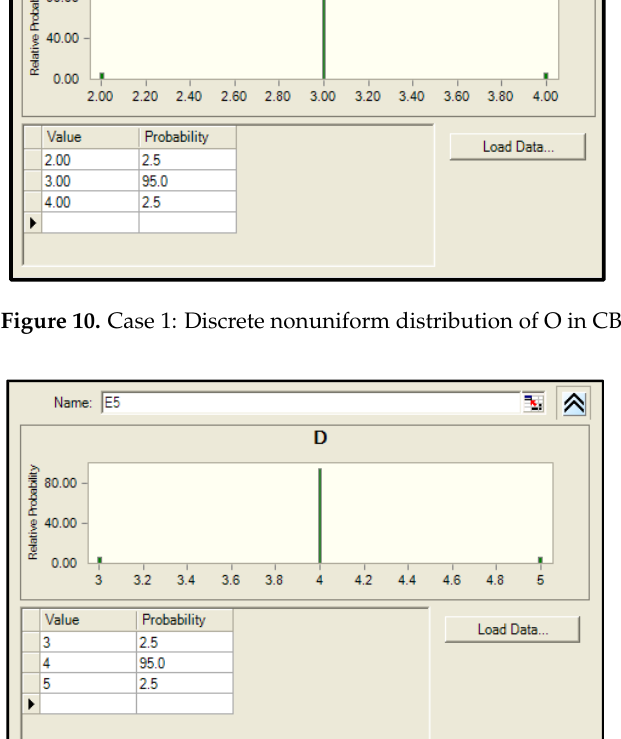
Figure 11. Case 1: Discrete nonuniform distribution of D in CB software.